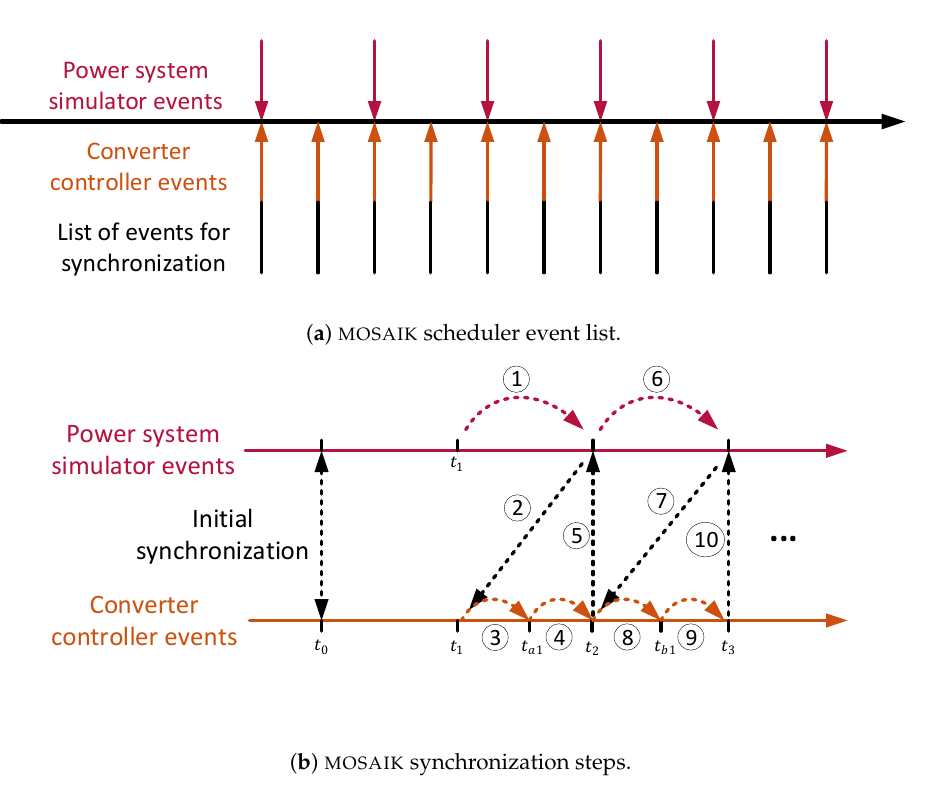
Figure 3. Synchronization mechanism in MOSAIK